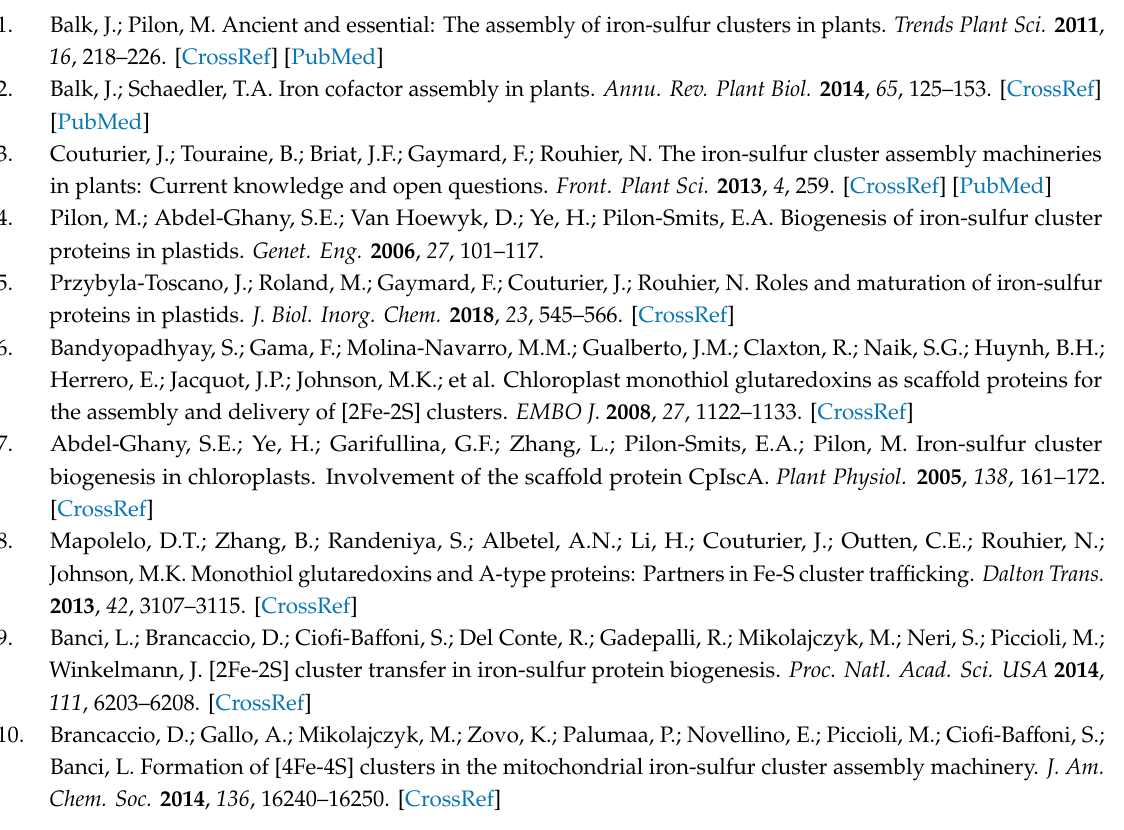
Supplementary Materials: The following are available online at http: // www.mdpi.com / 1422-0067 / 21 / 21 / 8121 / s1, Figure S1. Arabidopsis thaliana NFU1, NFU2 and NFU3 protein sequences. Figure S2. Quantitative analysis of GFP fluorescence in Arabidopsis thaliana ProNFU:gNFU-GFP transgenic lines. Table S1. List of significantly varying proteins in the Arabidopsis thaliana nfu3-2 mutant relative to wild type. Table S2. List of proteins specifically present in the Arabidopsis thaliana nfu3-2 mutant or in the wild type. Table S3. Detailed localization of variant proteins. Table S4: Detailed localization of proteins under-accumulated specifically in nfu3-2, or in nfu2-1 or in both mutants. Table S5: Detailed localization of proteins over-accumulated specifically in nfu3-2, or in nfu2-1 or in both mutants. Table S6. Primers used in this